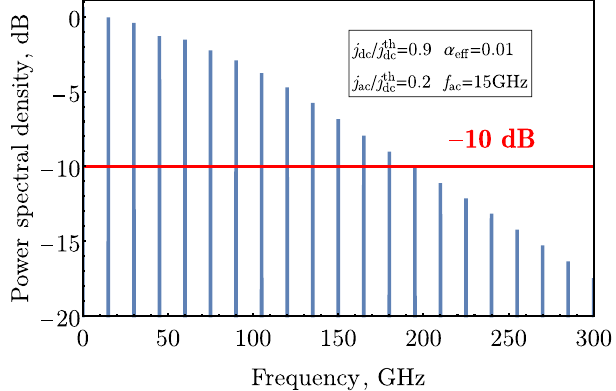
Figure 5. Numerically simulated frequency comb (spectrum of a periodic sequence of spikes) generated by an AFM SHO. Spectrum is normalized by the amplitude of the first harmonic at f ac = 15